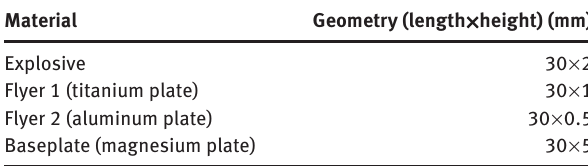
Table 3: Geometry parameters of three-layer plates used in the